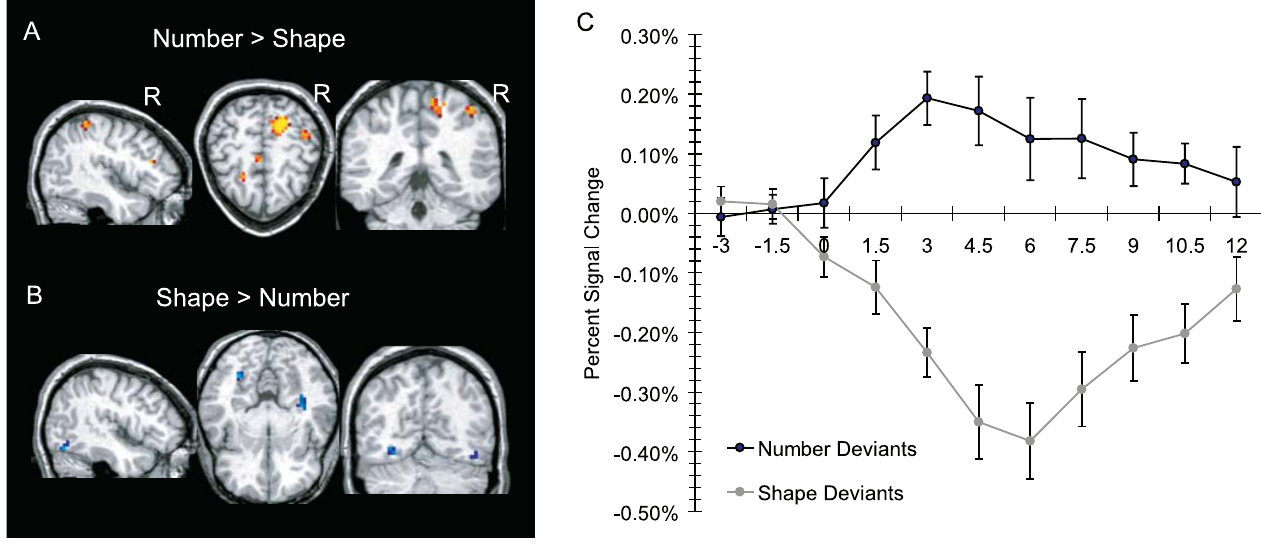
Figure 3. Child Participant’s fMRI Results (A) Regions that were more active during the presentation of number compared to shape deviants ( p , .05, cluster size . six functional voxels). (B) Regions that were more active during the presentation of shape compared to number deviants ( p , .05, cluster size . six functional voxels). (C) Time course of activity (percent signal change) for number-selective (number . shape) regions in the IPS, averaged from individually-drawn functional regions of interest from the IPS, from 3 s pre-stimulus to 12 s post-stimulus. DOI: